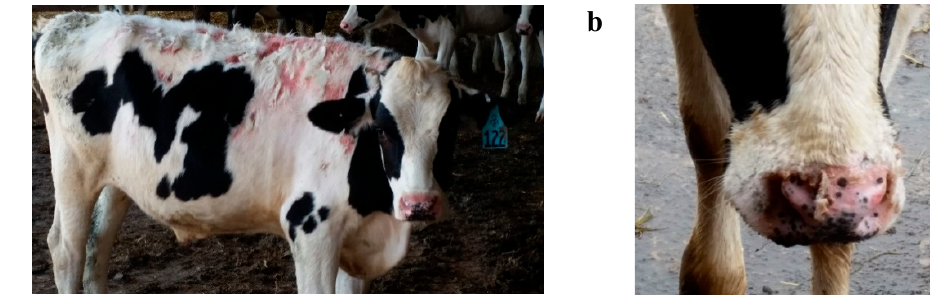
Figure 3. ( a ) Steer with clinical signs of photosensitivity on unpigmented skin. ( b ) Blistering on muzzle caused by photosensitivity.